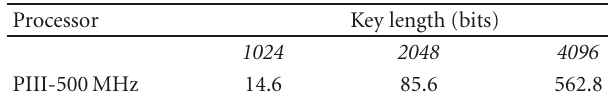
Table 1: RSA signature timings (ms) per packet on 500MHz Pentium III